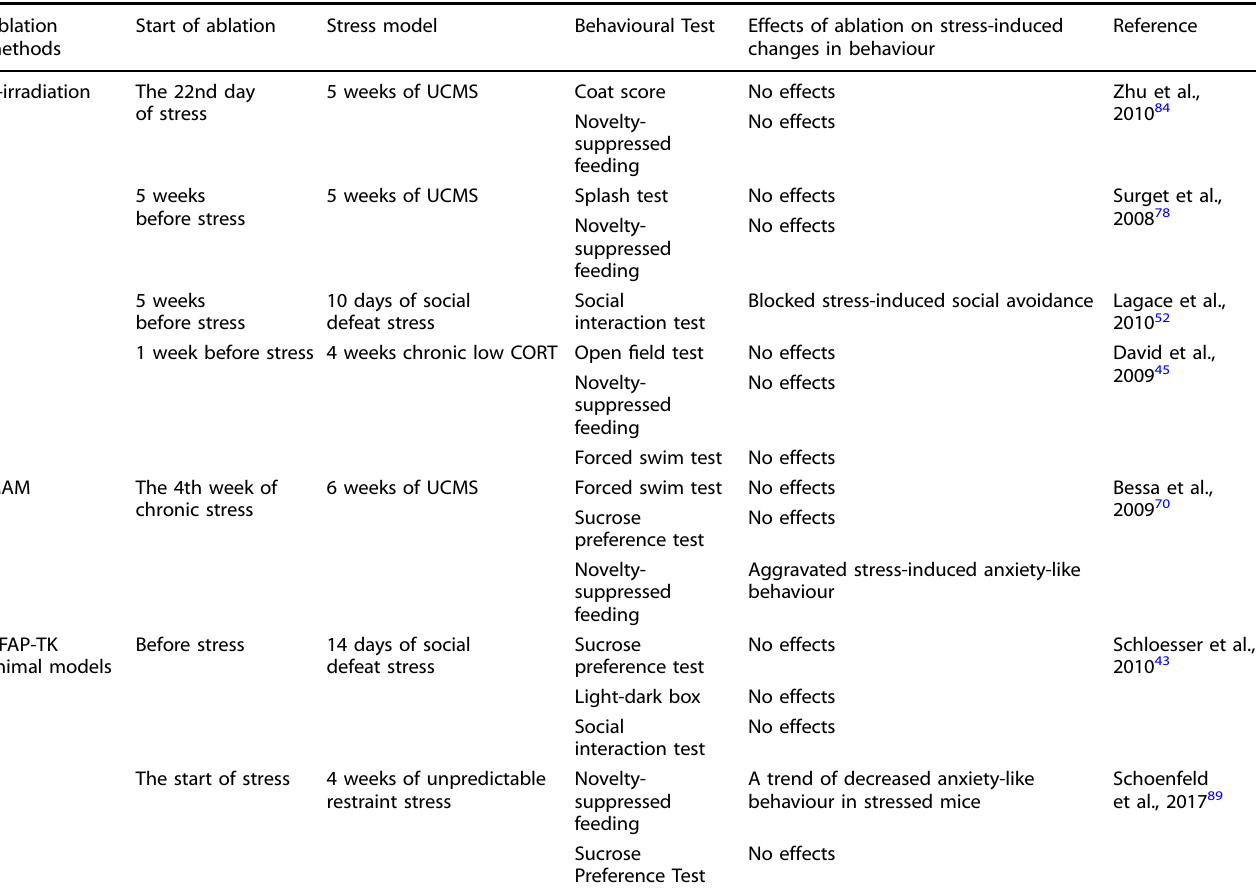
Table 2. Effects of ablating adult neurogenesis on mood-related behaviours in stressed